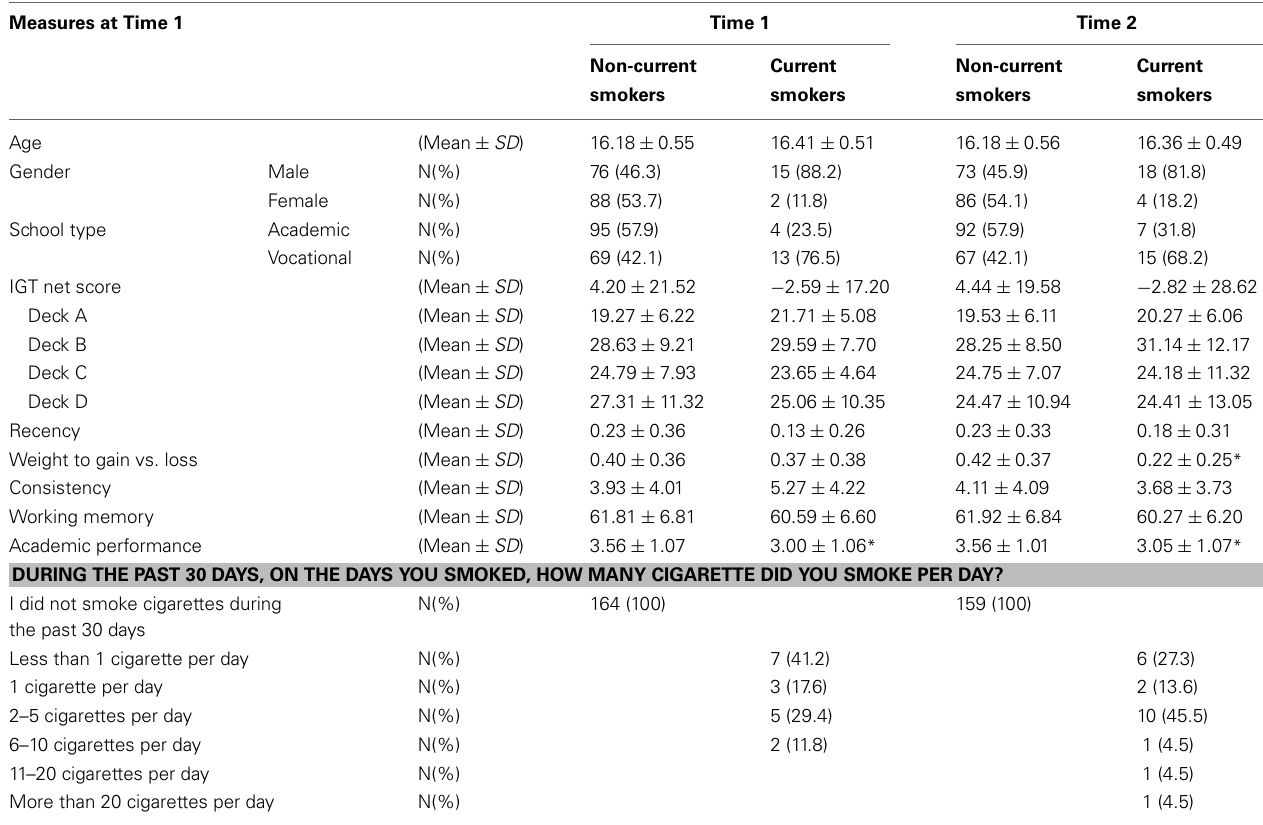
Table 2 | Measures in non-current and current